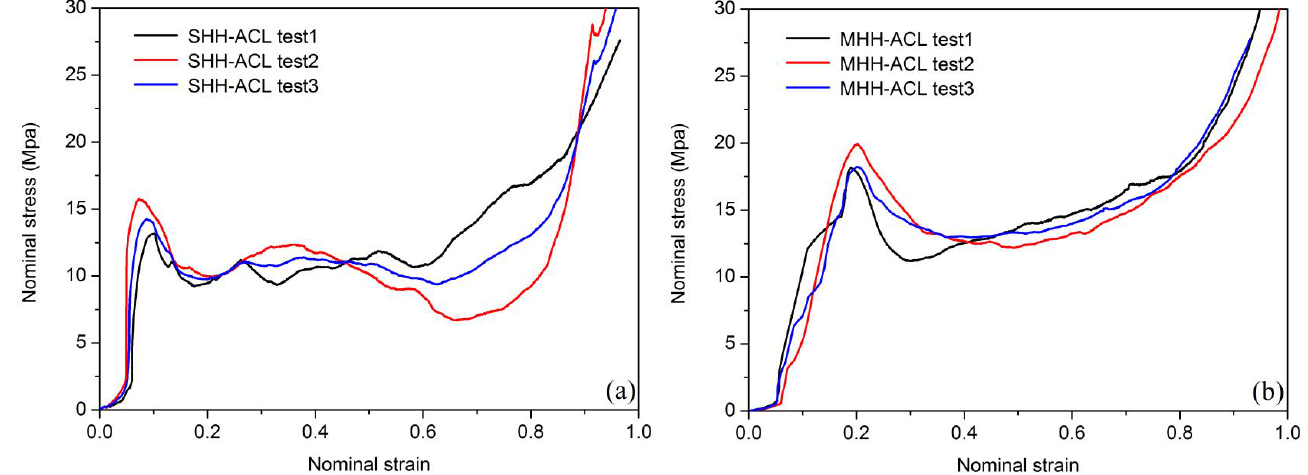
Figure 7. Nominal stress–strain curve of axial compression loading: (ACL) ( a ) SHH-ACL test, ( b ) MHH-ACL test. The stress–strain curves of two honeycombs radial compressions are described